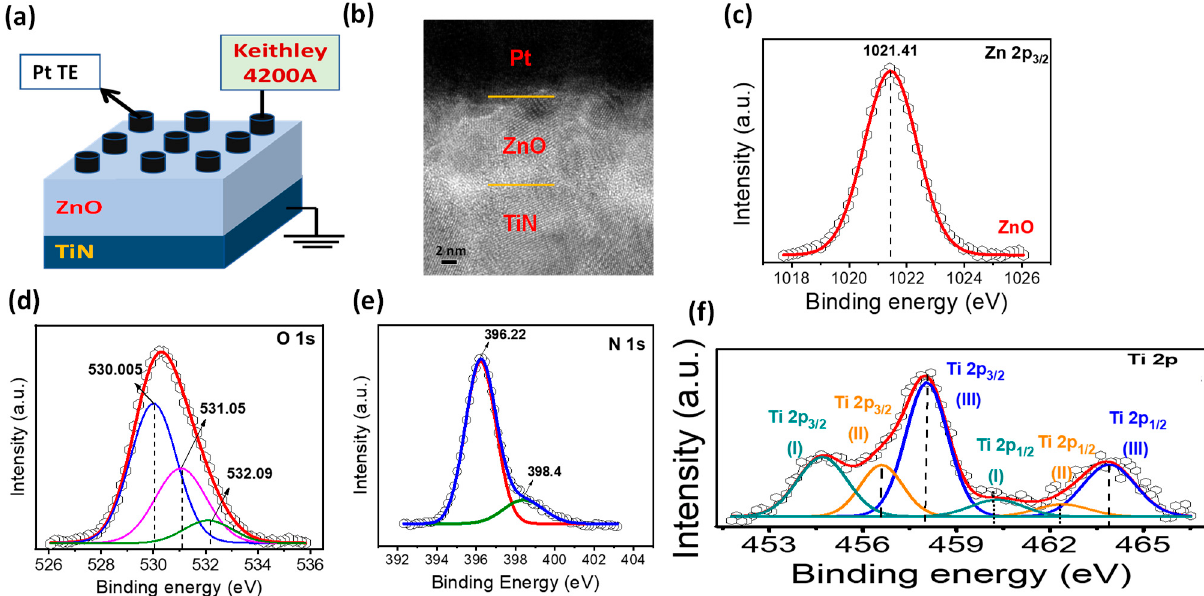
Figure 1. ( a ) Schematic diagram of Pt/ZnO/TiN. ( b ) Cross-sectional TEM image of a single-layer device; XPS spectra of ( c ) Zn 2p, ( d ) O 1s, ( e ) N 1s, ( f ) Ti 2p.